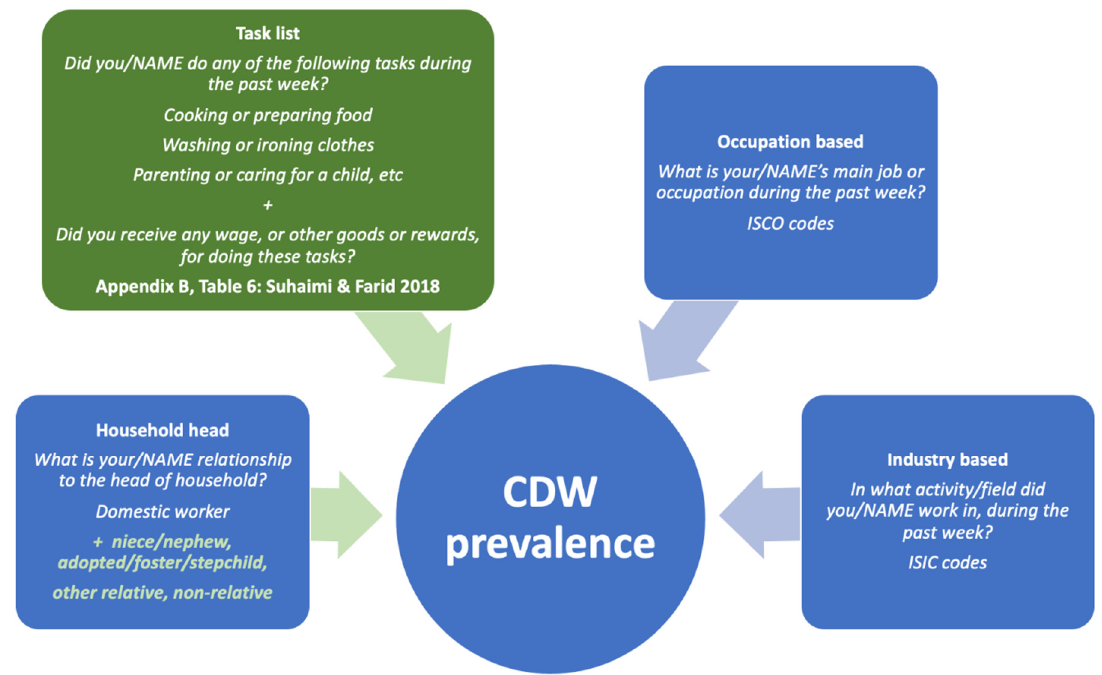
Figure 3. Recommended methods and questions for CDW prevalence in labour force surveys and child labour surveys.